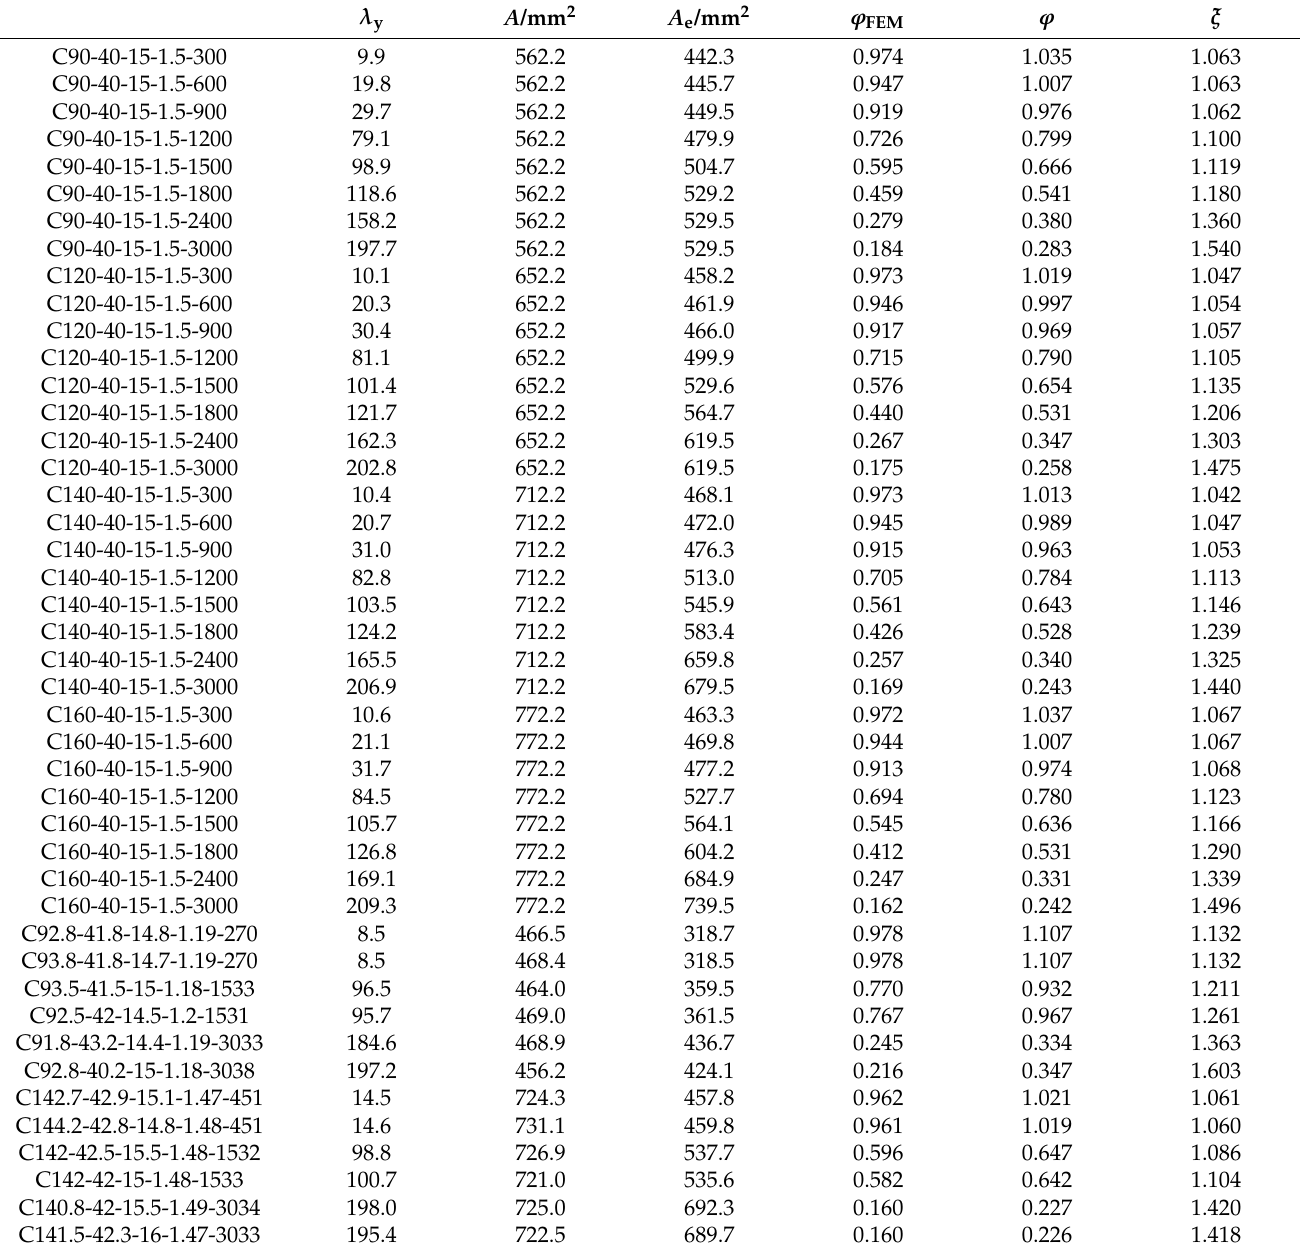
Table A2. Comparison of stability factor and correction factor of combined factor.